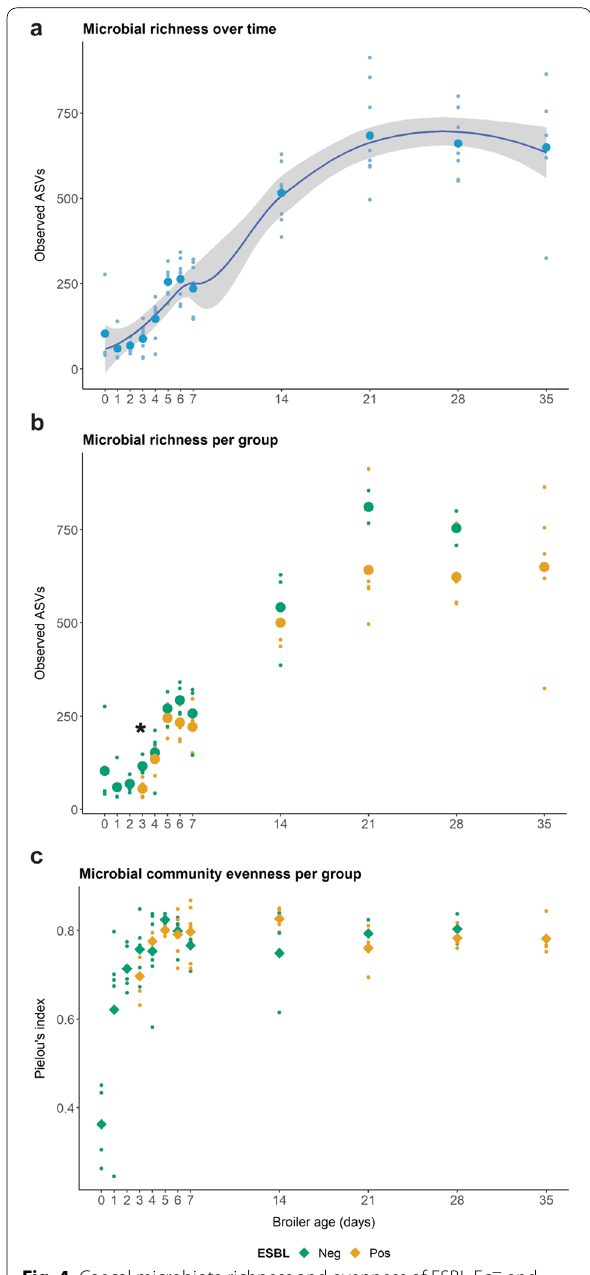
Fig. 4 Caecal microbiota richness and evenness of ESBL‑Ec − and ESBL‑Ec + broilers. a Observed microbiota richness in all broilers during their production life cycle. Small dots represent the amplicon sequences variants (ASVs) observed in each individual broiler and enlarged dots represent the ASVs mean from all broilers samples in each time point. The grey area represents the 95% confidence interval. Age significantly predicted microbial richness over time ( p < 0.001). b Comparison of microbiota richness between ESBL‑Ec − and ESBL‑Ec + broilers. The asterisk denotes a p < 0.05 for the